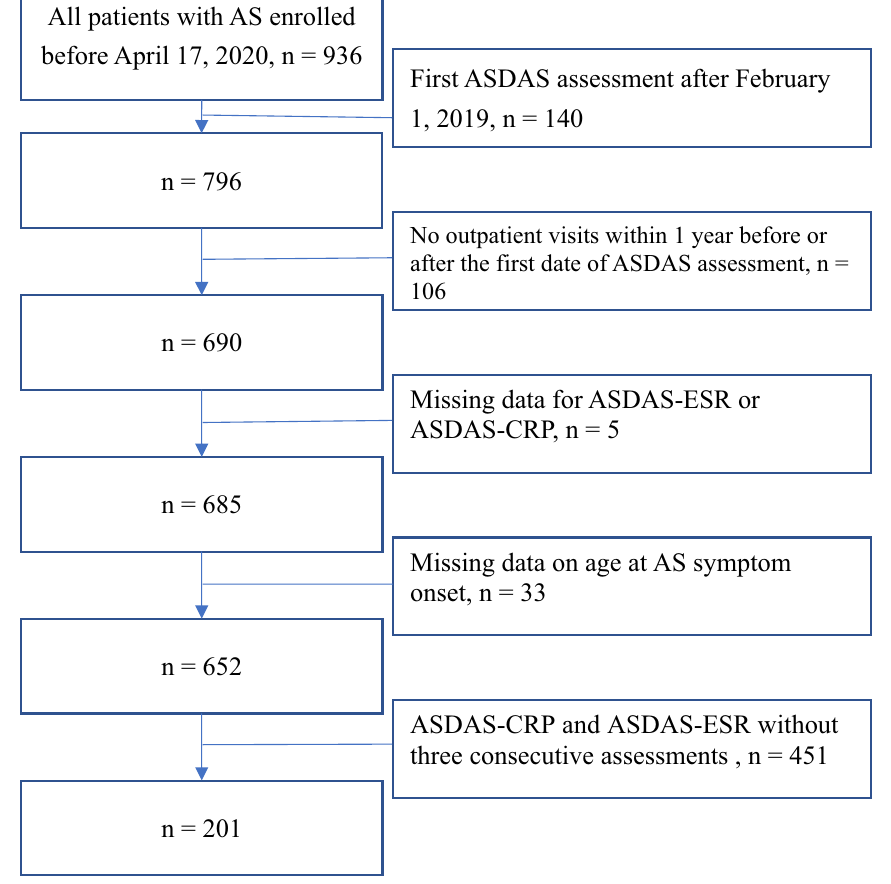
Figure 1. Flowchart of patient